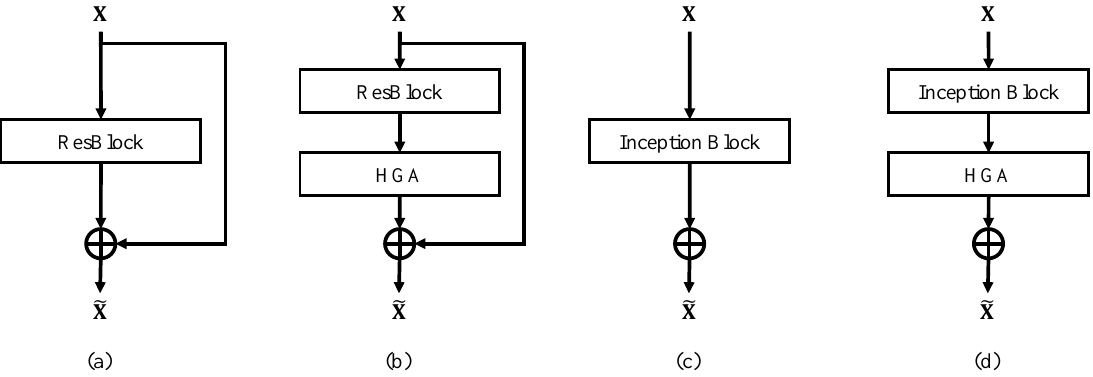
Figure 2. Applications of HGA on different network designs. ( a ) The vanilla ResBlock [15]. ( b ) The application of HGA on ResBlock. ( c ) The vanilla Inception Block [14]. ( d ) The application of HGA on Inception